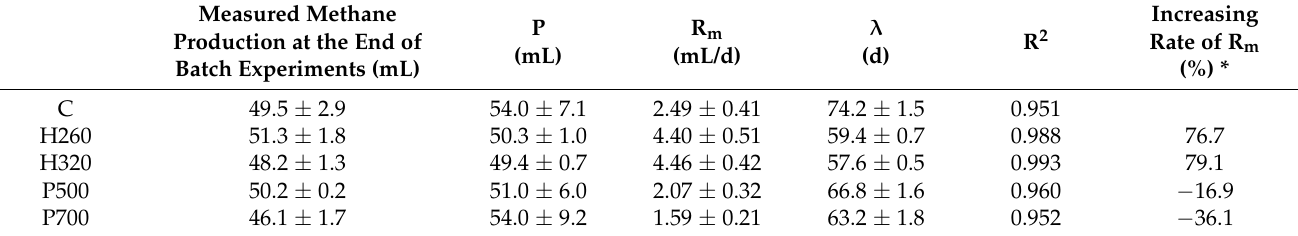
Table 1. Summary of the kinetic parameters of methane production by carbon